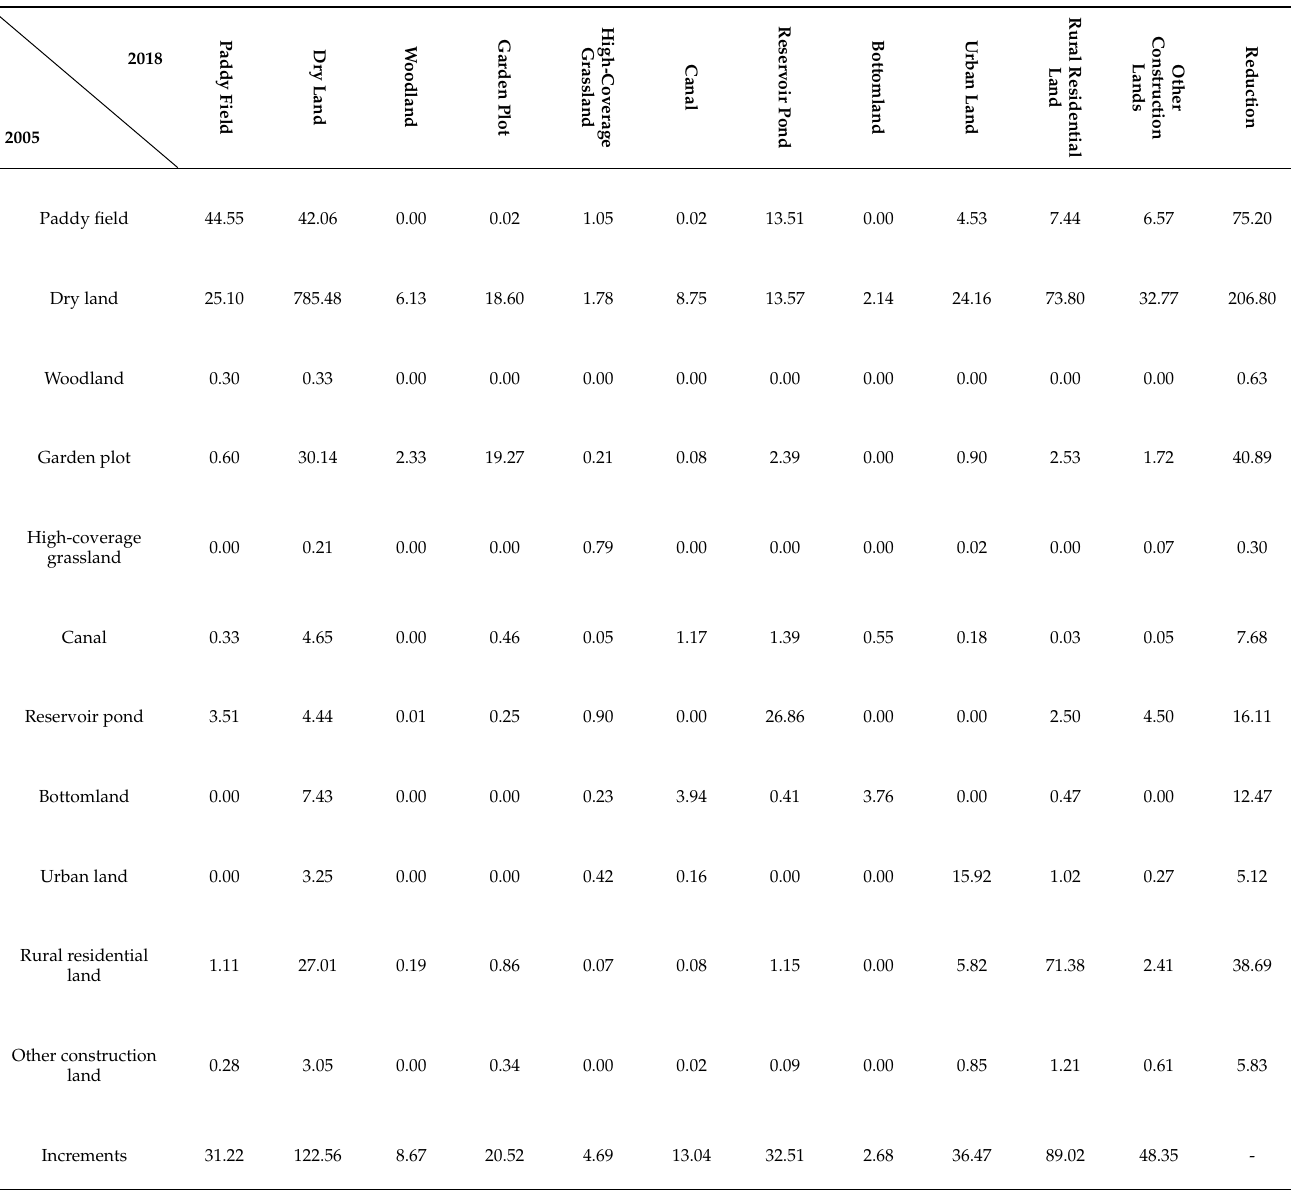
Table 3. Landscape area transfer matrix from 2005 to 2018 (Unit: km 2